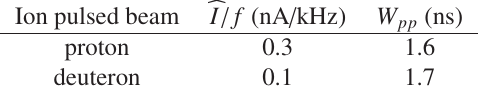
I / f ) and the (cid:31)